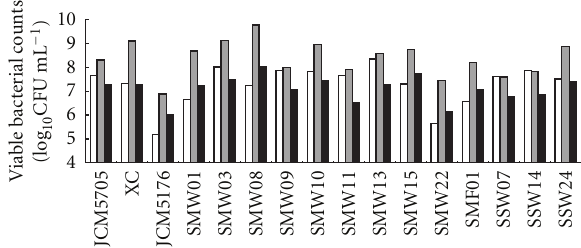
Figure 3: Viable bacterial counts of strains of mutans group streptococci in single cultures at 0 and 16 h and in dual cultures with E. faecium WB2000 at 16h (log 10 CFU mL − 1 ). JCM5705, S. mutans JCM5705; Xc, S. mutans Xc; JCM5176, S. sobrinus JCM5176; SMWs and SMF, clinical S. mutans strains; SSWs, clinical S. sobrinus